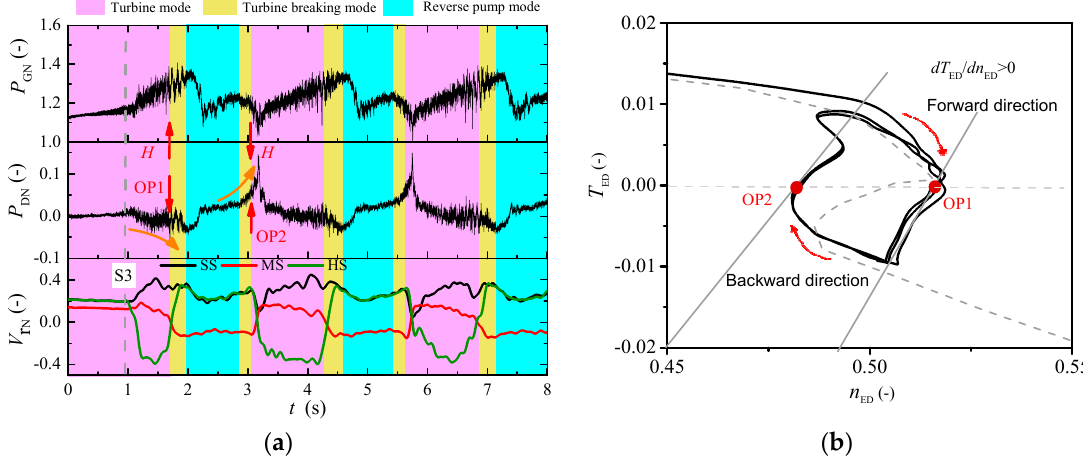
Figure 4. Dynamic trajectories and time histories of operating parameters at GVO 15°. ( a ) Variation of pressure and radial velocity; ( b ) dynamic trajectories.